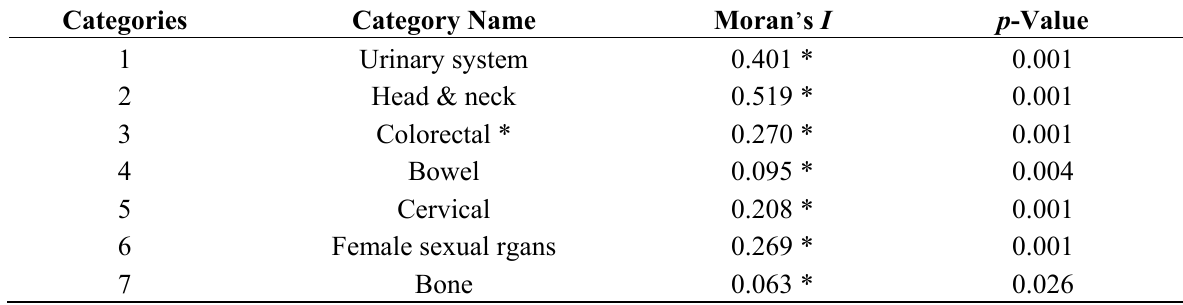
Table 3. Global Moran’s I statistics of each principal